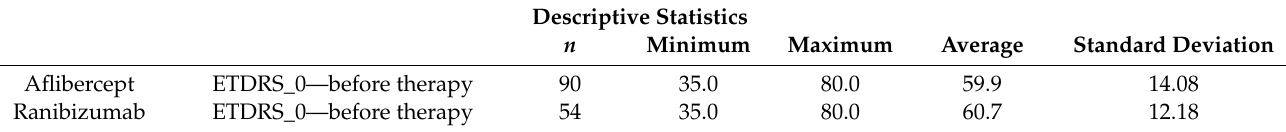
Table 3. Characteristics of study groups in terms of baseline visual acuity (BCVA).